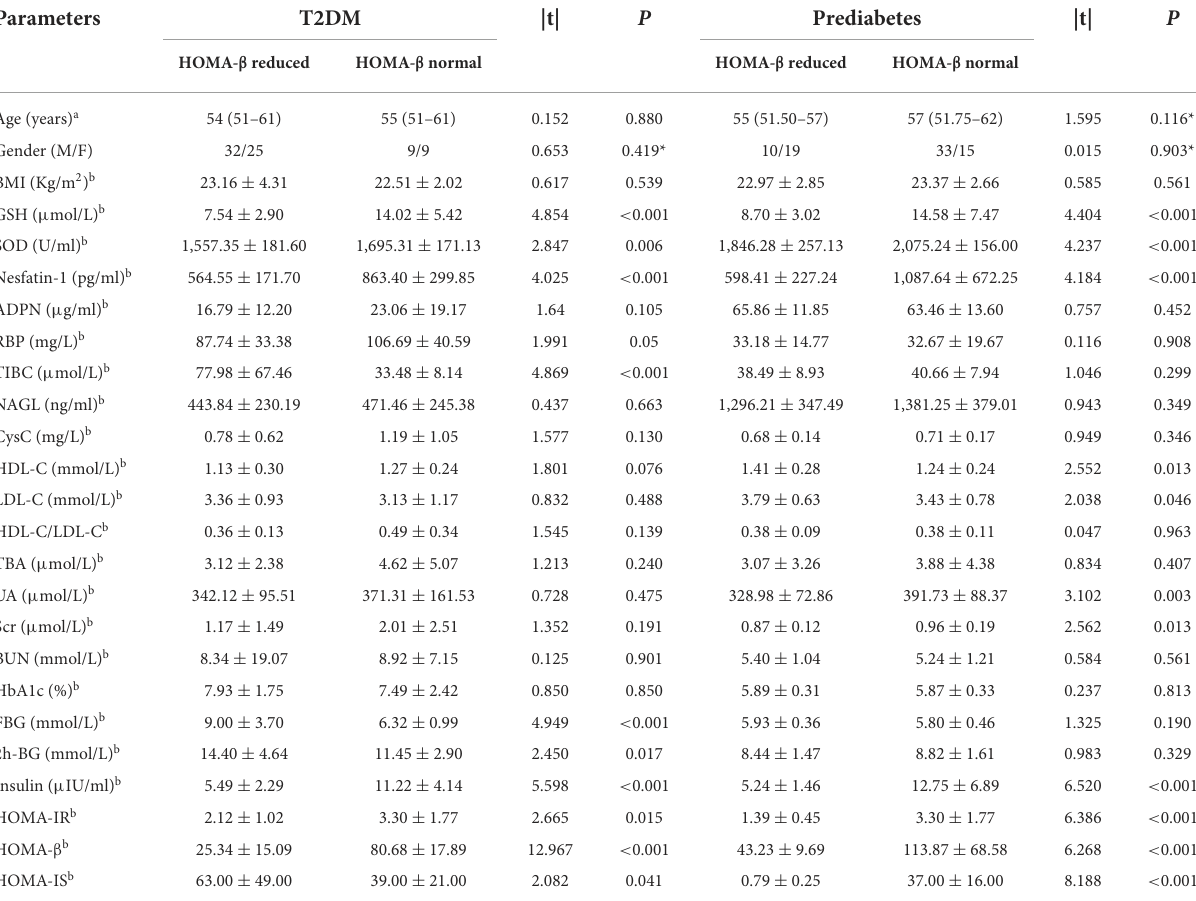
TABLE 3 Anthropometric and clinical characteristics of the subgroups divided by HOMA- β .